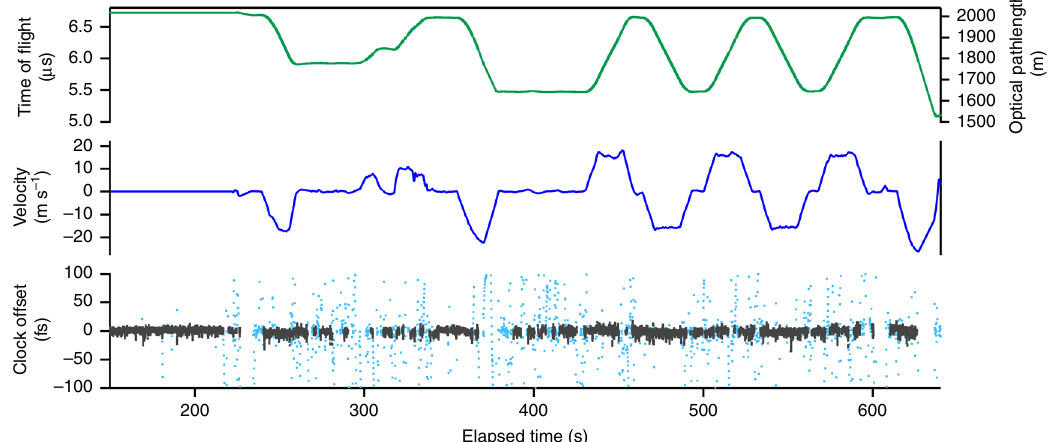
Fig. 3 Synchronization results for a link to the fl ying quadcopter. The results shown are the time-of- fl ight (optical pathlength), closing velocity, and clocks ’ time offset as measured by the out-of-loop veri fi cation channel. The clock ’ s time offset is given for periods of active synchronization (gray dots) at the full ~2 kHz update rate and for all times (cyan dots) at a 10 Hz sampling rate. The latter clearly shows the walkoff of the clocks during longer duration fades. The walkoff of the clock offset can exceed ~100 femtoseconds for fades longer than 1 s. The standard deviation is 3.7 fs for active synchronization at the ~2 kHz update rate (also see Supplementary Movie 1)